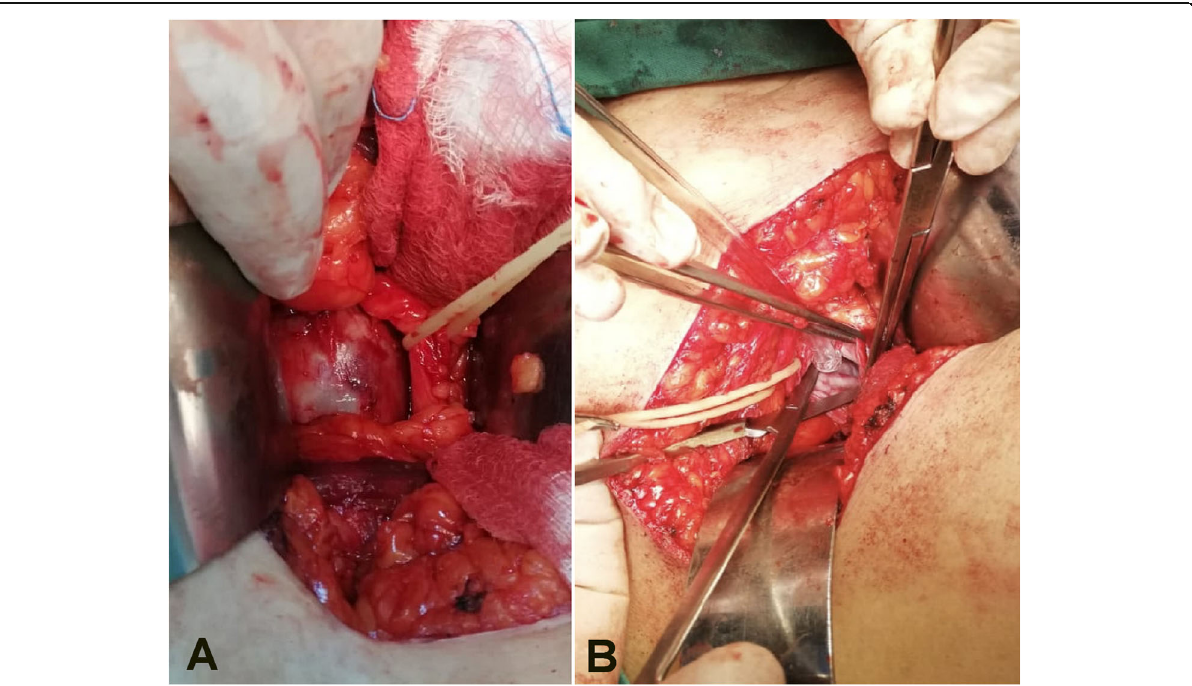
Fig. 2 An intraoperative picture showing a the hydatid cyst and lumbar nerve root, traction is exerted over the nerve. The surgical field is isolated using a surgical pack soaked with chlorhexidine; b the hydatid cyst cavity is opened containing small daughter cysts